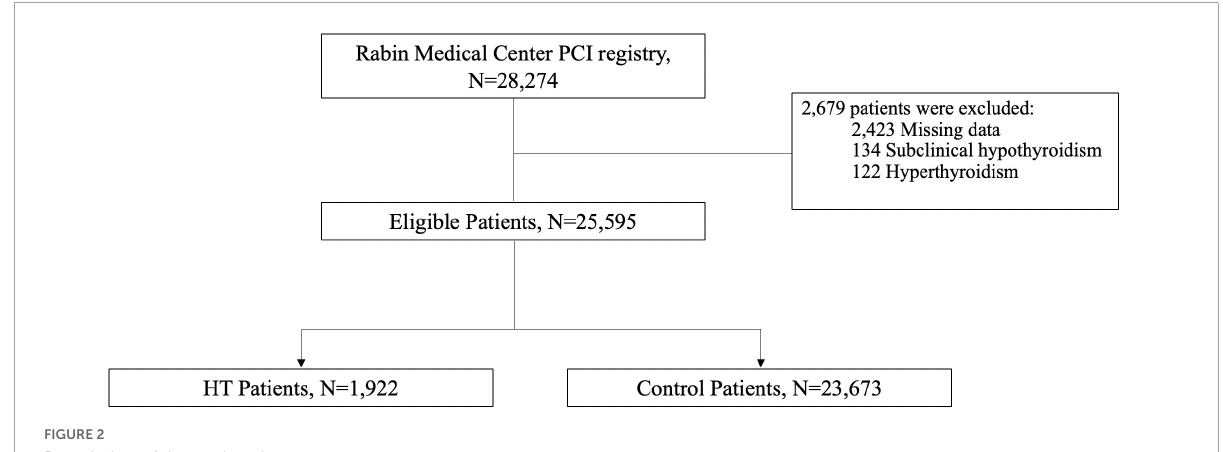
FIGURE2 Description of the study